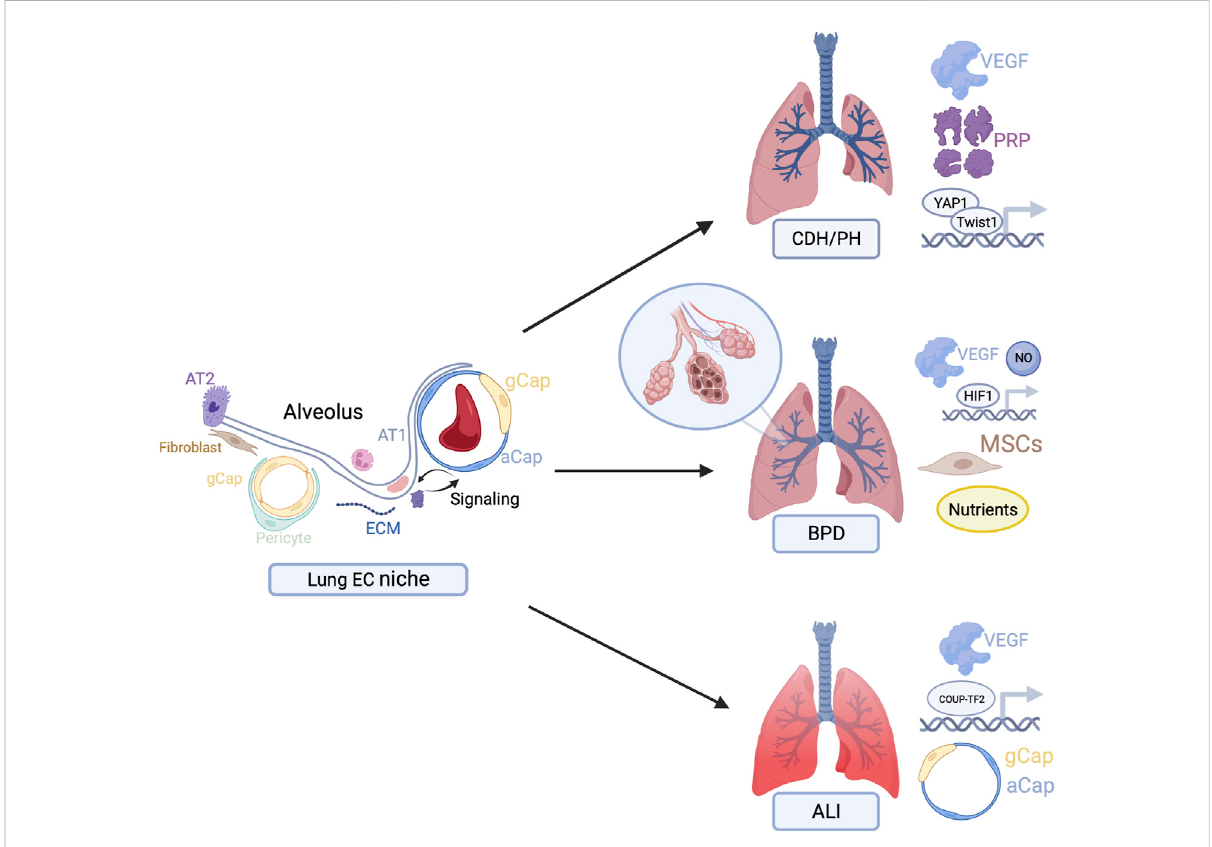
FIGURE 1 Overview of potential therapeutic targets to stimulate endothelial cell-driven angiogenesis in congenital diaphragmatic hernia (CDH), bronchopulmonary dysplasia (BPD), and acute lung injury (ALI). Figures created with